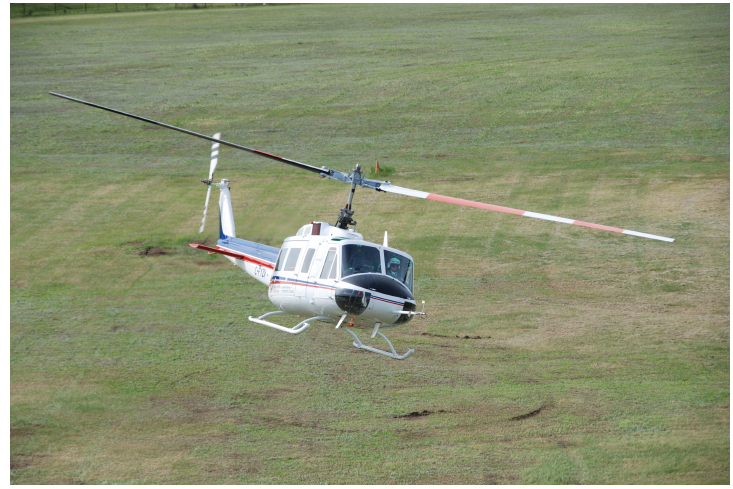
Figure 1. NRC Bell 205 airbourne